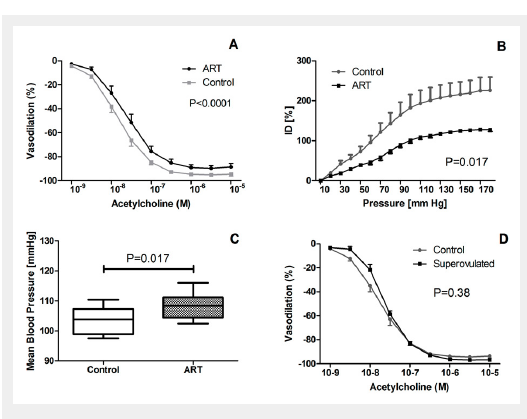
Flow-mediated vasodilation (FMD) of the brachial artery and right ventricular to right atrial (RV-RA) pressure gradient in children conceived by assisted reproductive technologies (ART), in offspring of mothers suffering from preeclampsia and in age- and gender- matched healthy control children (Panel A and B). FMD and pulse wave velocity (PWV) in fertile parents of control children and of sterile parents ART children (Panel C and D). Relationship between maternal age and FMD in ART children (Panel E). FMD in control children, ART children and children naturally conceived during stimulation of the ovulation in the mother (Panel F). Data are expressed as mean ± SEM. ANOVA and Bonferroni post-hoc test (for Panel A, B and F).